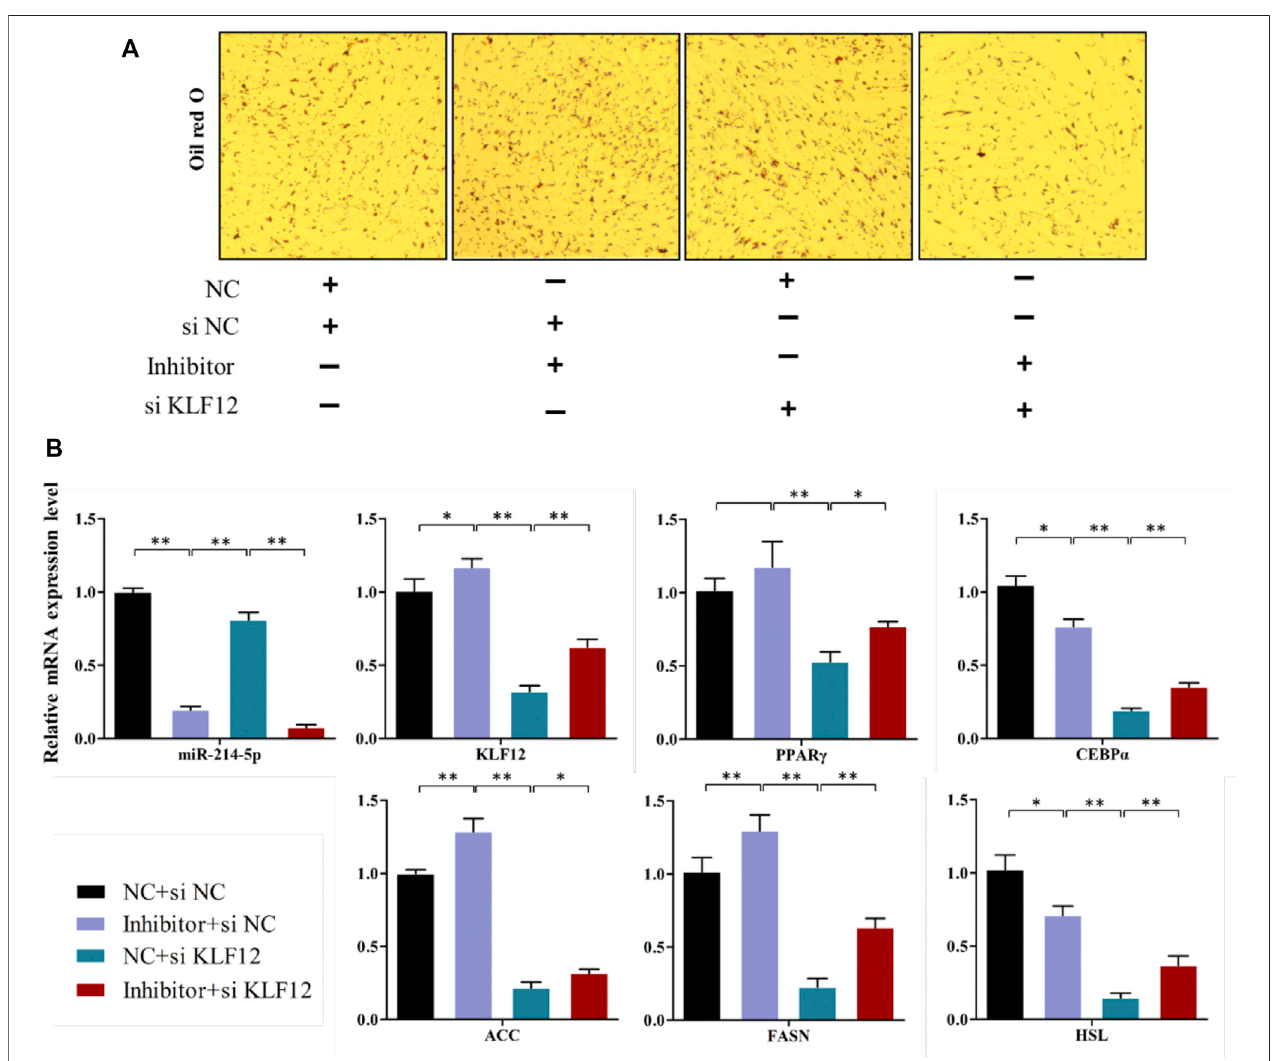
FIGURE 7 | KLF12 is a functional target of miR-214-5p. (A) Oil red O staining ( × 200). (B) mRNA expression levels of key adipogenic regulatory genes.